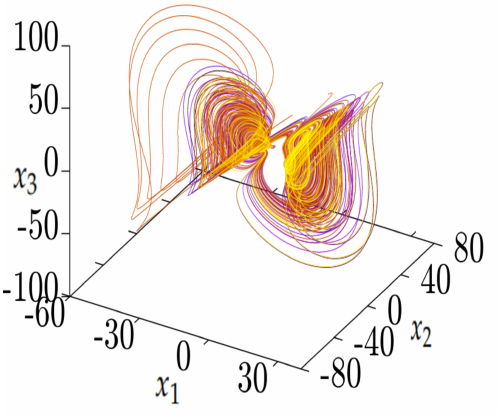
Figure 1. Chaotic attractor of system (2).